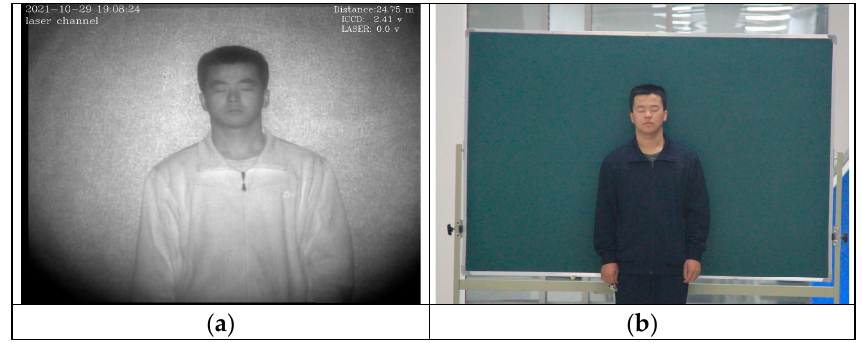
Figure 1. Laser and visible images. ( a ) Laser image. ( b ) Visible image.